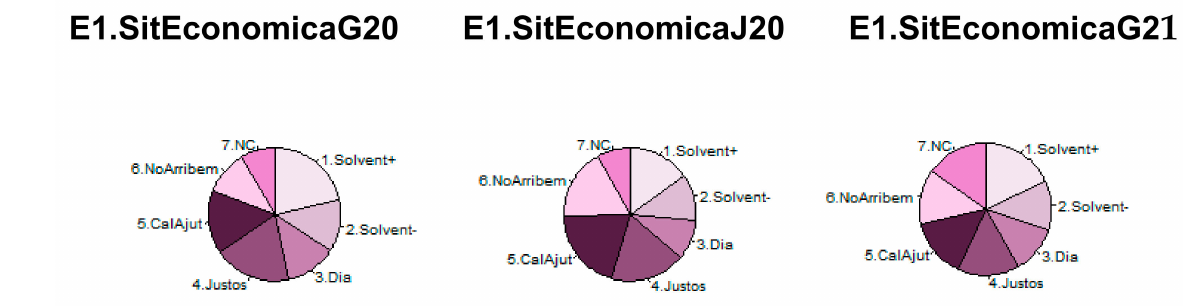
Figure 11. Grid of Pie Charts of question E1. Economic